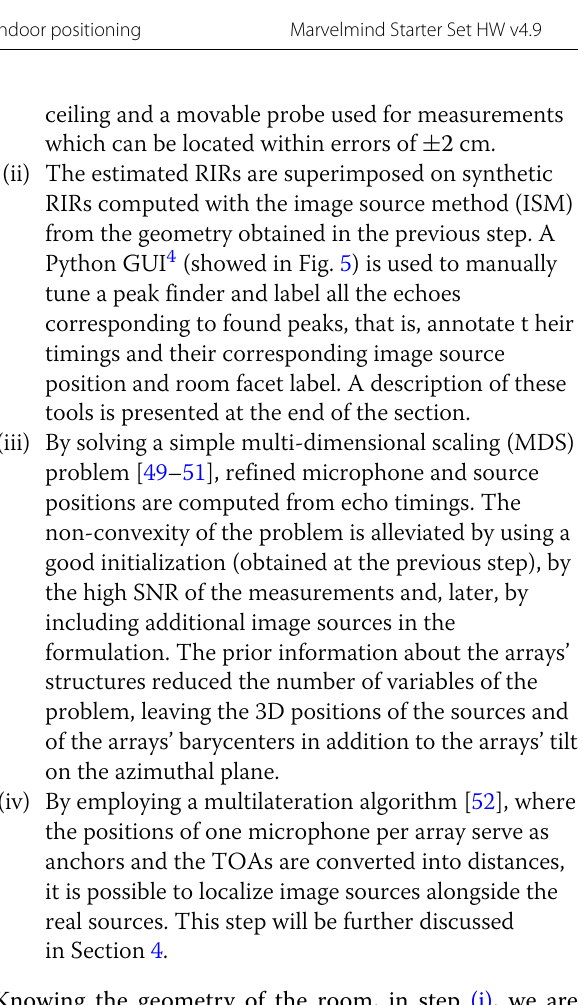
Fig. 4 Broad view picture of the acoustic lab at Bar-Ilan University. This picture corresponds to the configuration 010001 ∗